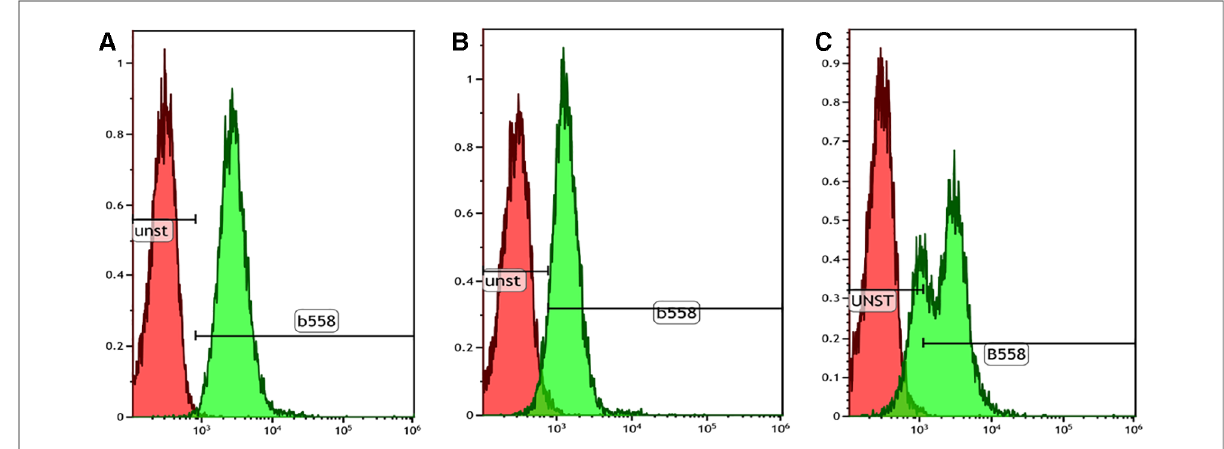
FIGURE 3 Cytochrome B558 expression in neutrophils by fl ow cytometry. ( A ) Healthy control showing normal B558 expression in the stained neutrophils (99.8% with stain index 9.7); ( B ) Index patient showing mildly reduced B558 expression in the stained neutrophils (71.3% with stain index 4.5); ( C ) Mother showing bimodal pattern of B558 expression suggestive of a carrier state of X-linked